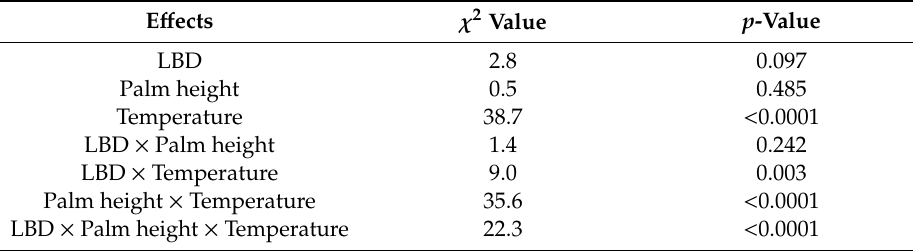
Table 1. Analysis of deviance table of the generalized linear mixed-effects model.